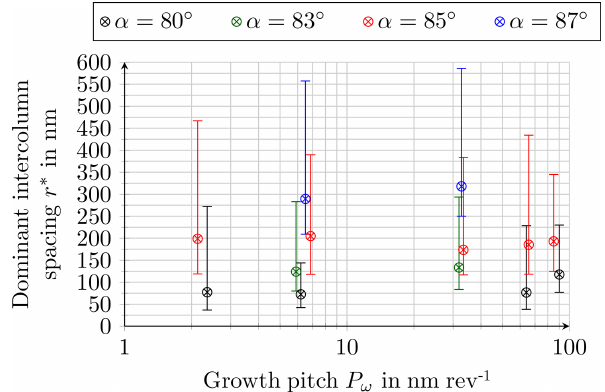
Figure 5. Dominant column spacing r ∗ versus growth pitch for dif- ferent deposition angles.